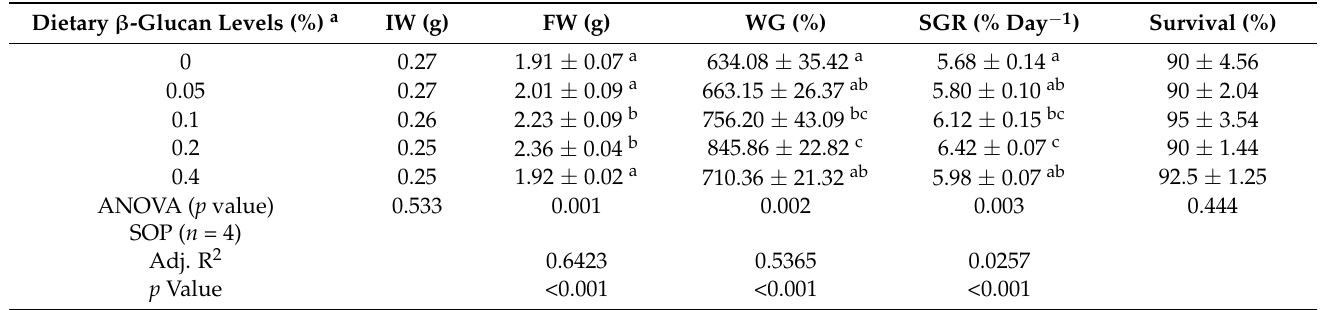
Table 2. Regression analysis of the growth performance of Juvenile L. vannamei fed different dietary β -glucan levels for 5